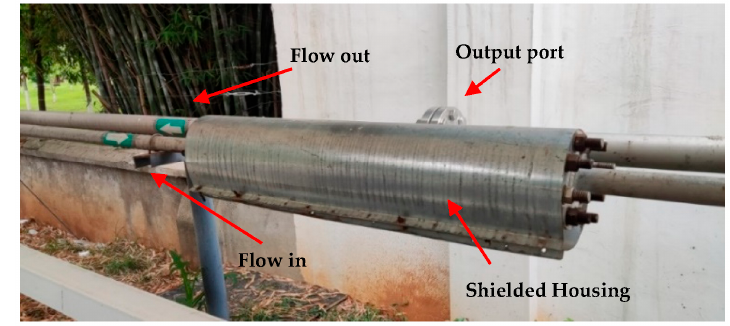
Figure 5. Experimental platform for water fl ow cycling.